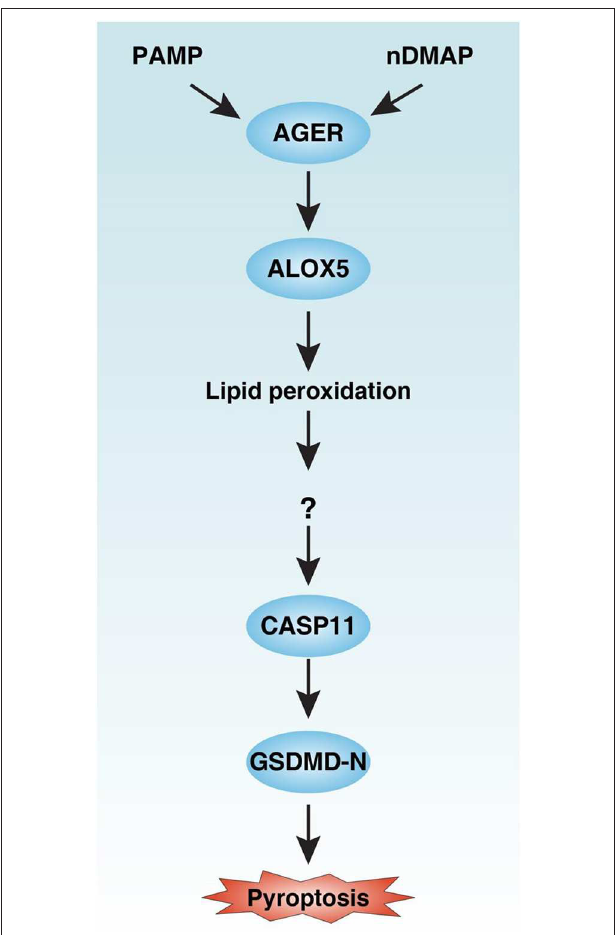
FIGURE 8 | Schematic summary of the role of the AGER-ALOX5 pathway in the regulation of caspase-11 inflammasome activation and pyroptosis. Activation of AGER by PAMP and nDMAP promotes ALOX5-dependent lipid peroxidation. Although the precise mechanism of action of lipid peroxidation remains unknown, the alteration of cellular redox status and the production of lipid peroxides may cause conformational change of CASP11 ( 27). CASP11 can cleave GSDMD to produce GSDMD-N to mediate pyroptotic cell death. PAMP, pathogen-associated molecular pattern; nDAMP, nuclear damage-associated molecular patterns; AGER, advanced glycosylation end-product specific receptor; ALOX5, arachidonate 5-lipoxygenase; GSDMD-N, N terminal domain of gasdermin